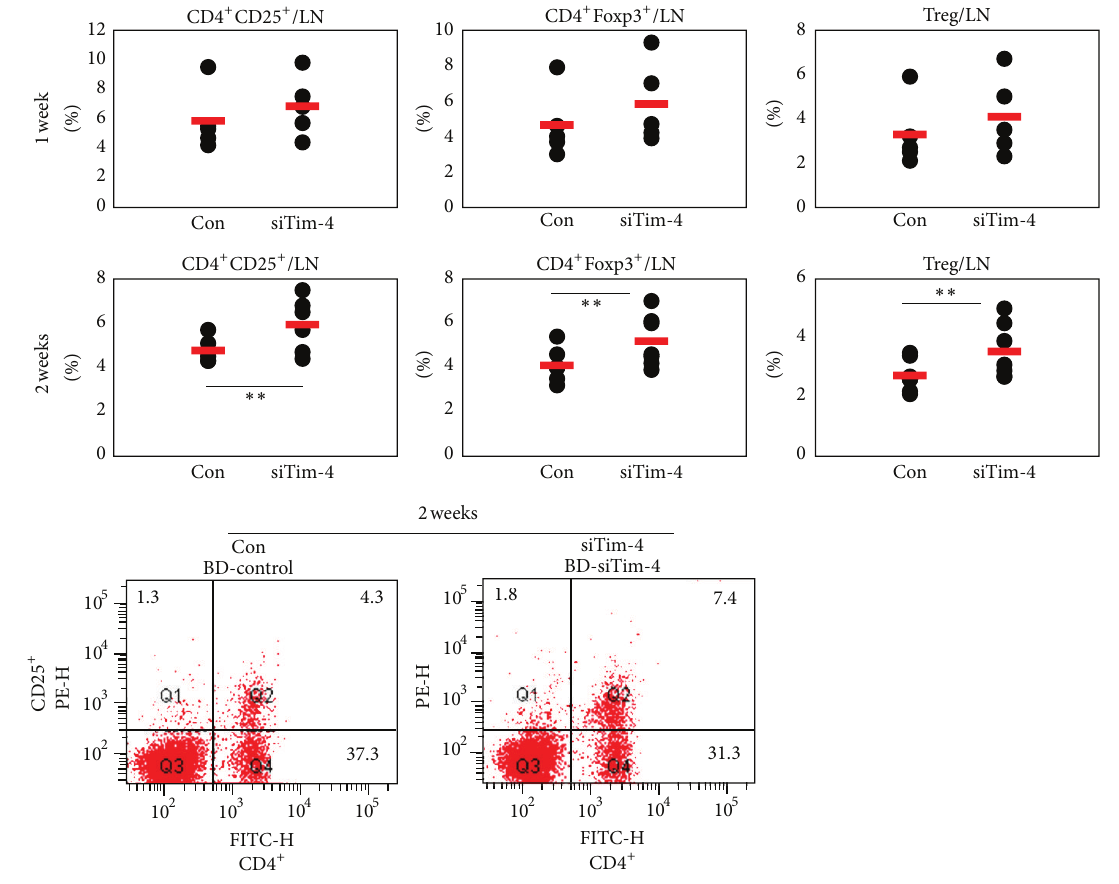
Figure 9: The frequencies of Treg cells were upregulated after treatment with siTim-4 in Behc¸et’s disease (BD) mice. Treg cells were confirmed by flow cytometry in lymph nodes of BD mice after treatment with siTim-4. At 1 and 2 weeks after the first treatment with siTim-4, the frequencies of CD4 + CD25 + , CD4 + Foxp3 + , and CD4 + CD25 + Foxp3 + Treg cells were compared between the siTim-4 and control groups (negative control siRNA treated groups) ( 𝑛 = 5 –7) ( ∗∗ 𝑃 < 0.05 ). The bottom panel shows CD4 + CD25 + in PBMCs at 2 weeks by FACS dot plot. Con: negative control siRNA injection to BD mice, siTim-4: Tim-4 siRNA injection to BD